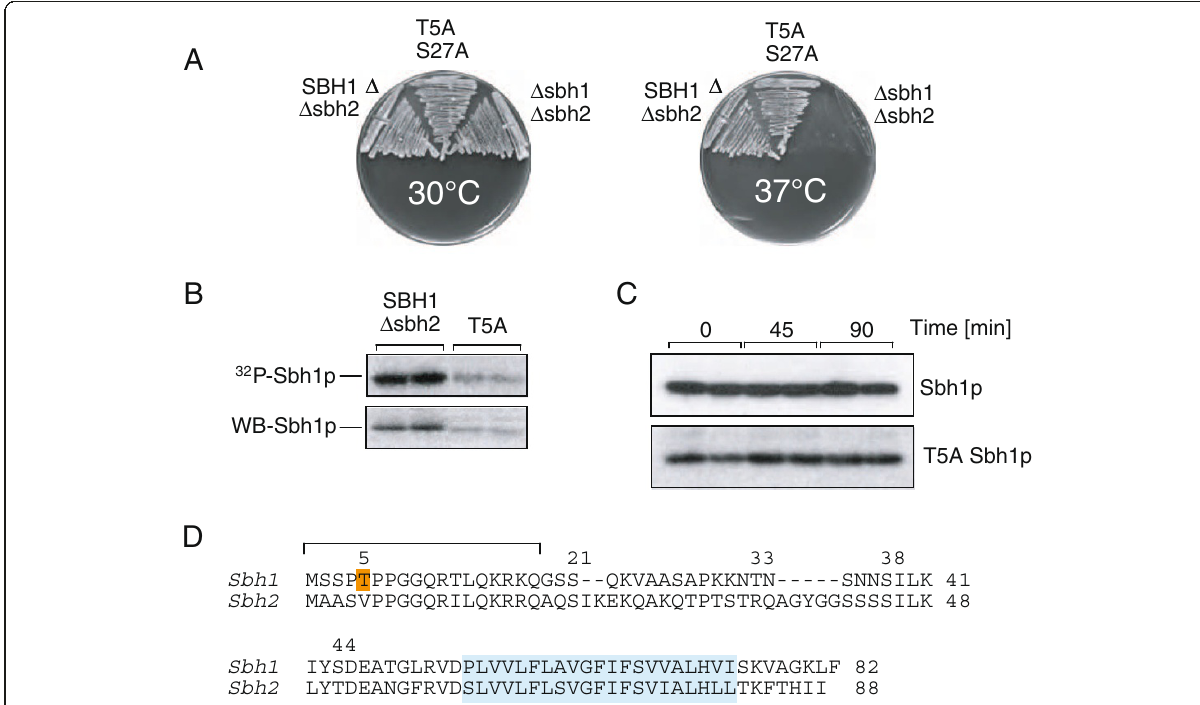
Figure 4 Mutation of the known phosphate acceptor site in SBH1. ( A ) The indicated sites were mutated to alanine, and mutant Sbh1 proteins expressed in a Δ sbh1 Δ sbh2 strain. The SBH1 Δ sbh2 strain was used as a control. Strains were grown on YPD plates at 30°C and 37°C for 2d. ( B ) Sbh1 mutant proteins from strains shown in (A) were labelled in intact cells with [ 32 P]phosphate; cells were lysed and proteins immunoprecipitated, separated on 15% SDS gels, and detected by autoradiography. Immunoprecipitated proteins were also detected by immunoblotting (lower panels). ( C ) SBH1 Δ sbh2 and sbh1-T5A Δ sbh2 strains were grown to early exponential phase, cycloheximide added to prevent further protein synthesis, samples taken at the indicated times, cells lysed, proteins resolved on SDS gels and Sbh1 proteins detected by immunoblotting. ( D ) Alignment of Sbh1p and Sbh2p. The identified phosphorylation site in Sbh1p is indicated in orange, transmembrane domains are shown in blue. The bracket denotes the peptide of Sbh1p against which our polyclonal antibody was